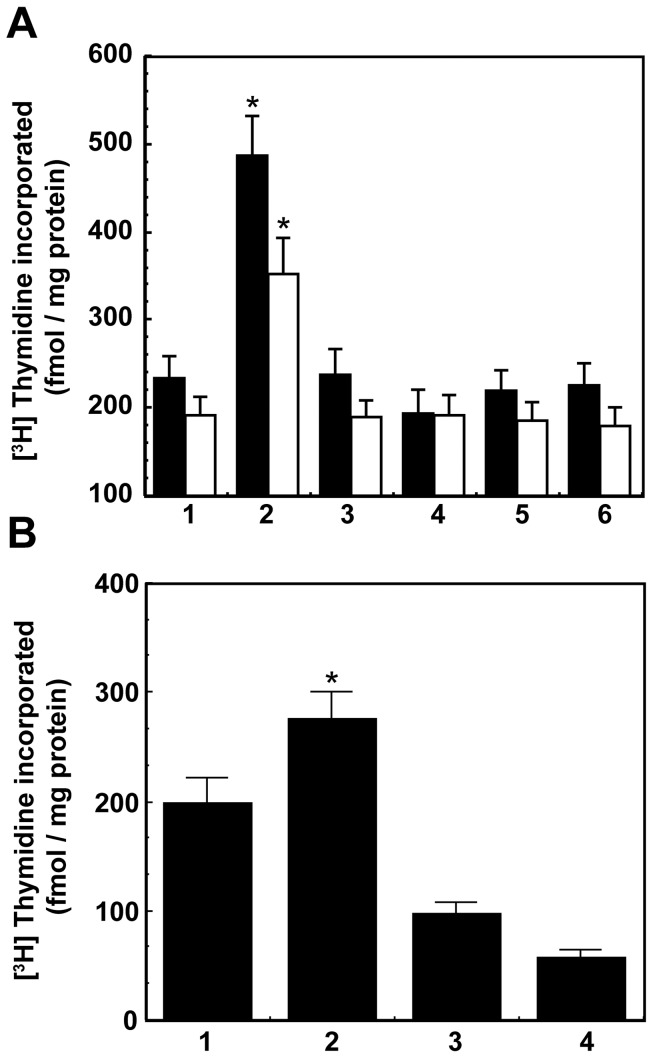
Inhibition of DNA synthesis by COX-2 (Panel A) and mTOR inhibitors (Panel B) in prostate cancer cells stimulated with 8-CPT-2Me-cAMP.The bars in Panel A and B are as in Figure 2. DNA synthesis as determined by quantifying the incorporation of [3H] thymidine into cellular DNA and is expressed as fmol [3H] thymidine incorporated mg protein and the data represent the mean ± SE from three independent experiments in each panel. Values significantly different from buffer and inhibitor-treated cells (Figure 3A) and from buffer and Torin1-treated cells (Figure 3B) at the 5% level are devoted by an asterisk (*).